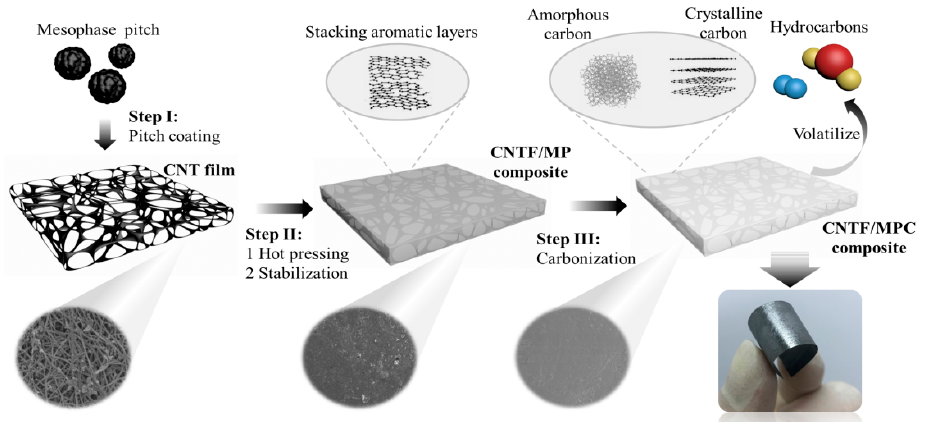
Figure 1. The preparation process of CNT film-reinforced pitch-based carbon nanocomposite by hot-pressing carbonization.